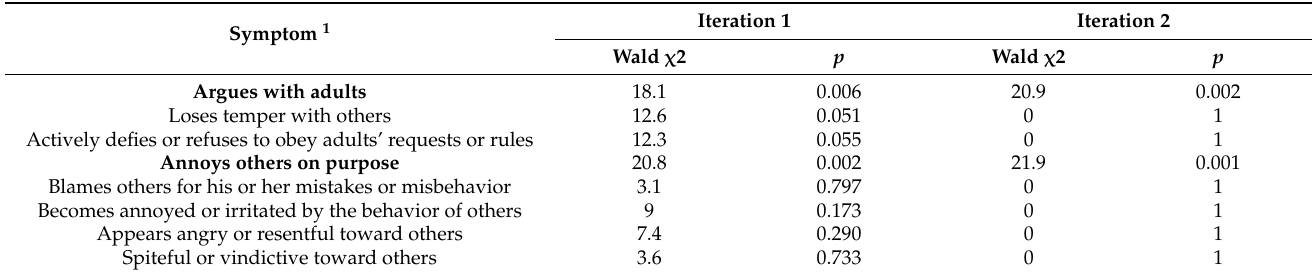
Table 1. Differential item functioning analysis of oppositional defiant disorder (ODD) symptoms.